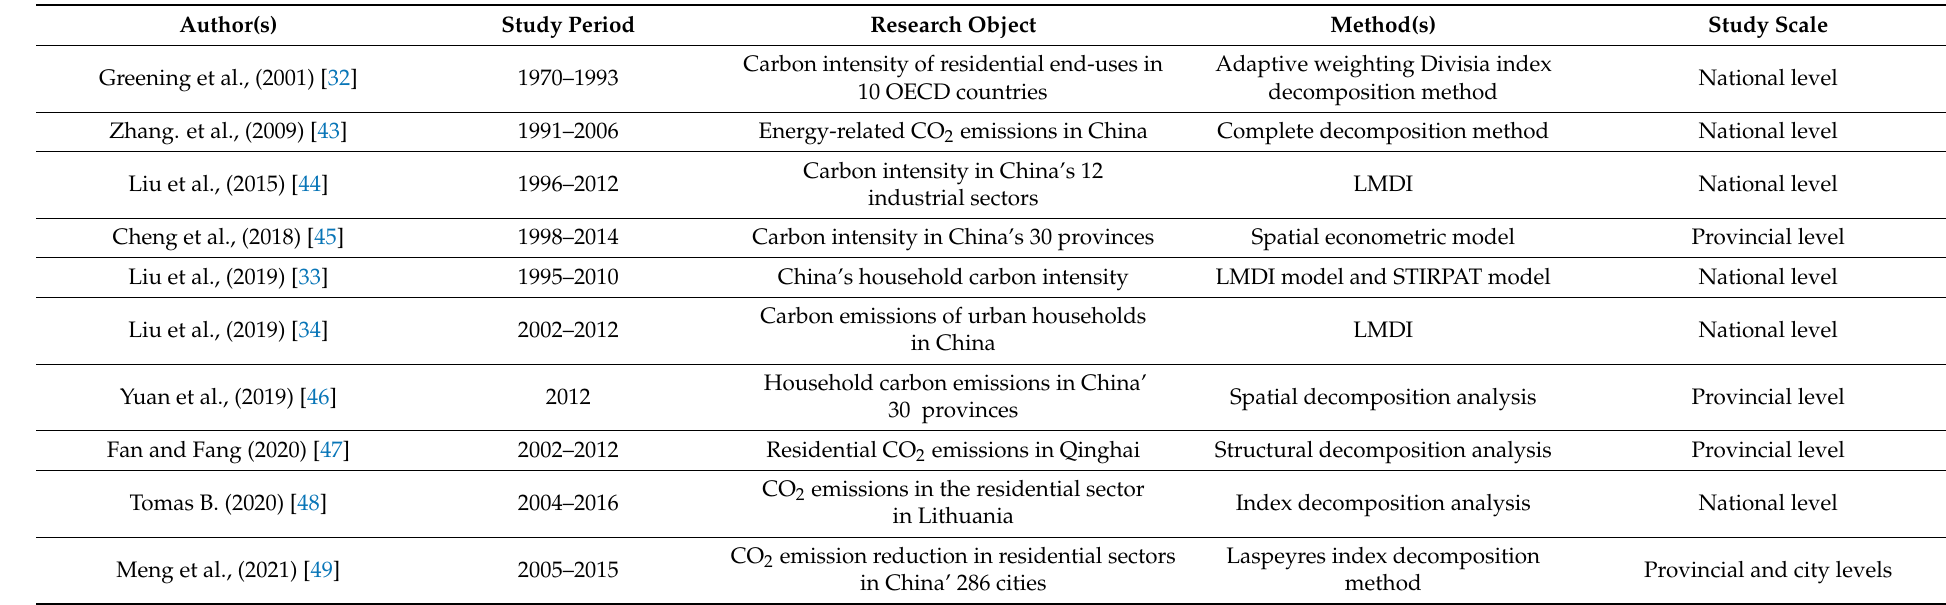
Table 1. Representative studies related to residential carbon emissions and carbon